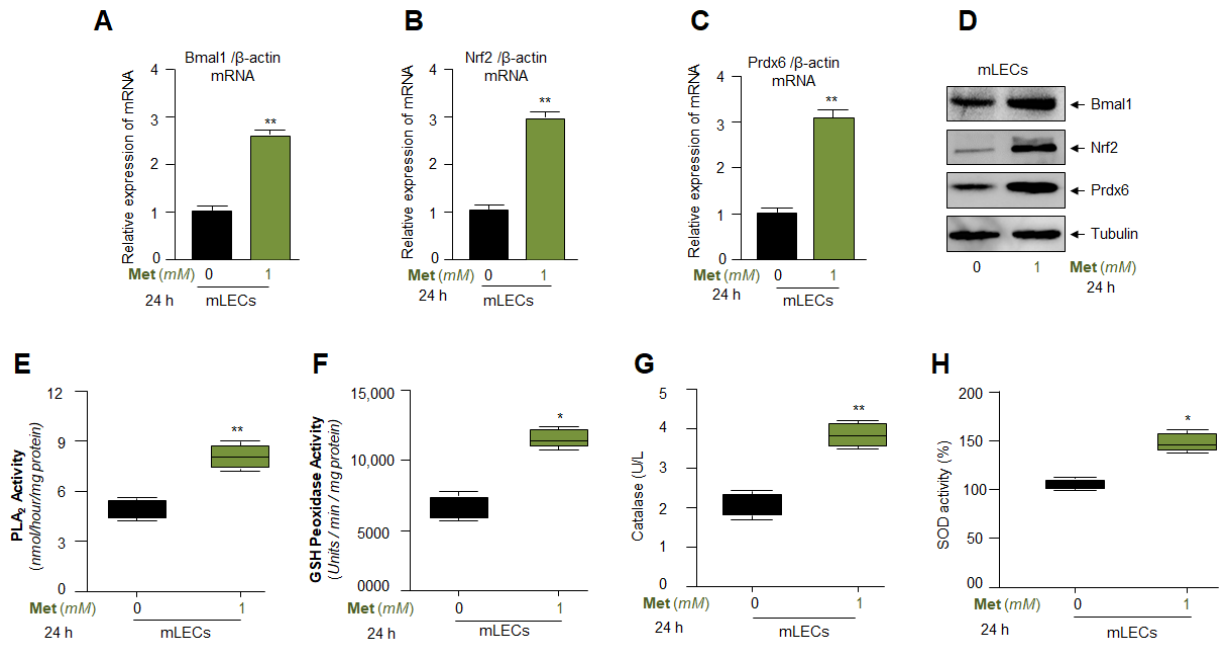
Figure 7. ( A – D ) Metformin augmented the expression of Bmal1, Nrf2 and target antioxidant gene, Prdx6 in mouse LECs. mLECs (5 × 10 5 ) were cultured in 60 mm culture plate and treated with Metformin for 24 h. Total RNA ( A – C ) and protein ( D ) were extracted and submitted to RT-qPCR and Western blot analysis with probes specific to corresponding molecules indicated. Bmal1, Nrf2 and Prdx6 transcripts and protein expression were significantly increased in response to Metformin. The data represent the mean ± S.D. from three independent experiments. Untreated vs. Metformin-treated; ** p < 0.001. ( E – H ) Metformin amplified Bmal1/Nrf2 target antioxidants enzymatic activities.